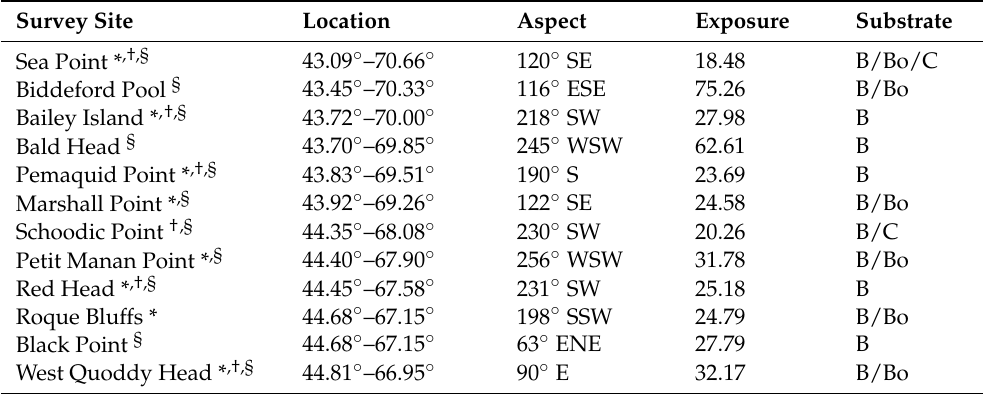
Table 2. Aspect, exposure, and primary substrate for exposed headland intertidal locations surveyed. Abbreviations for substrate: B, bedrock; Bo, boulder; C, cobble. Symbols show year of survey: *, 2004; † , 2007; § ,